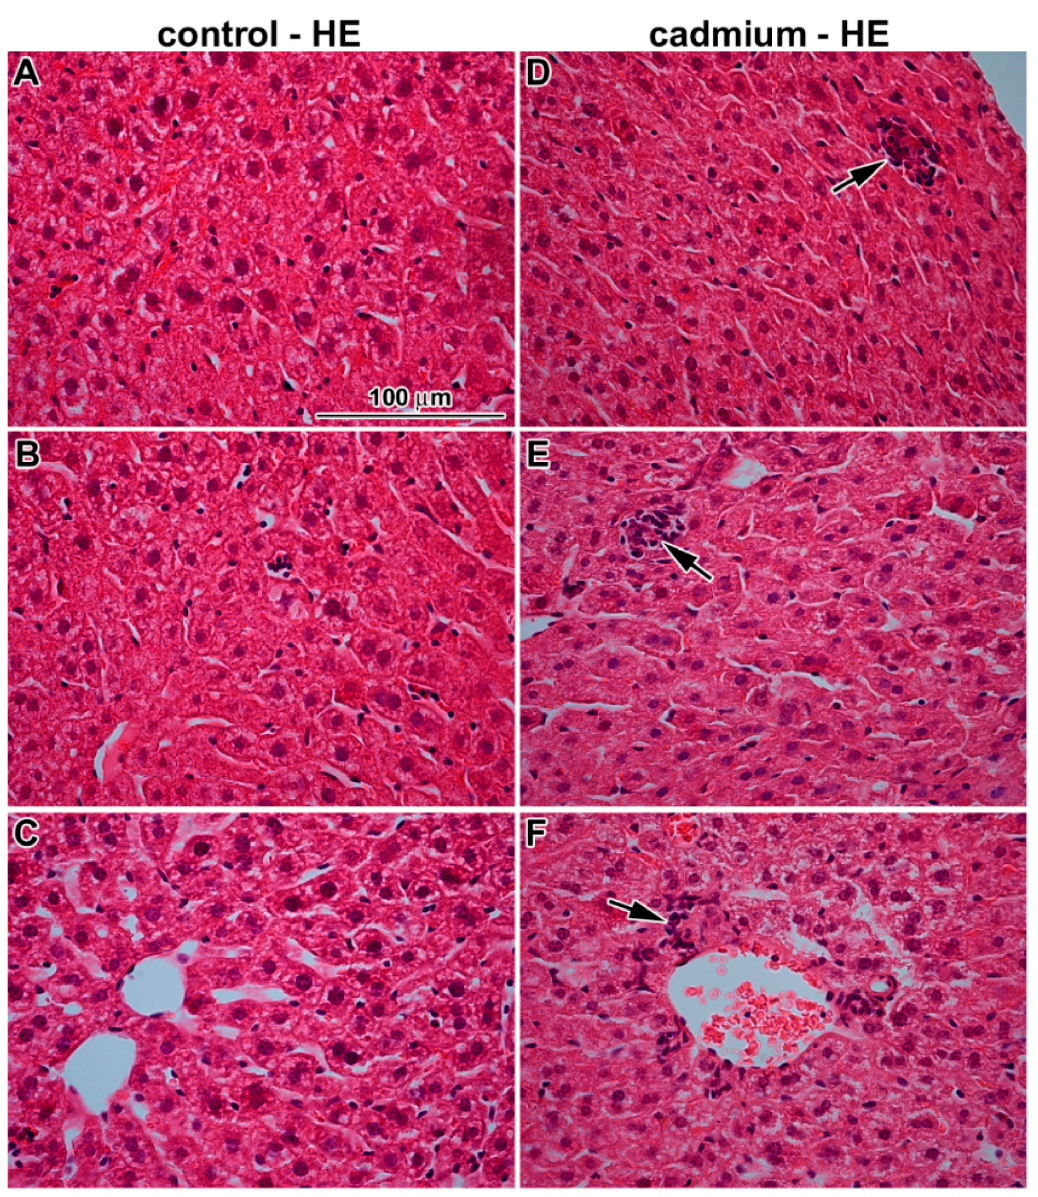
Figure 3. Effect of cadmium nanoparticles on liver following six weeks exposure to CdO nanoparticles: ( A – C ) control tissues; and ( D – F ) cadmium nanoparticles exposed tissues. Hematoxylin-Eosin. Scale bar = 100 µm. Arrows show small areas of necrosis.